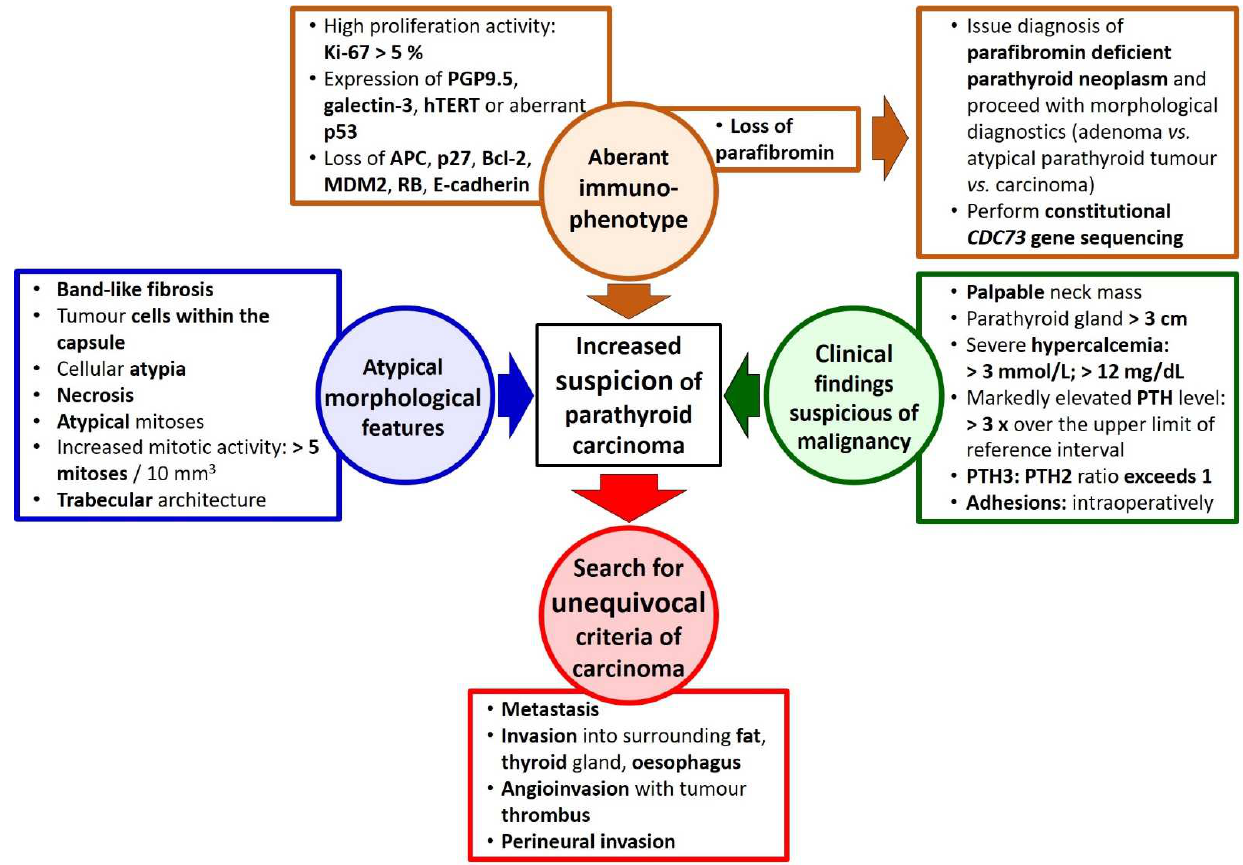
Figure 2. Suspicious features and unequivocal diagnostic criteria of parathyroid